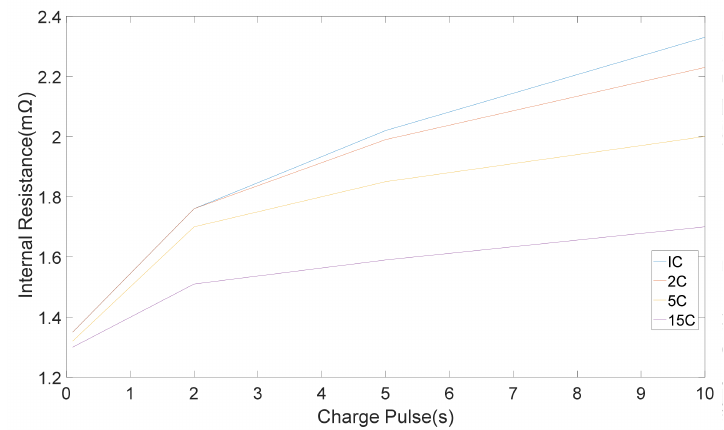
Figure 5. Internal resistance (m Ω ) computed from various amplitude charge pulses